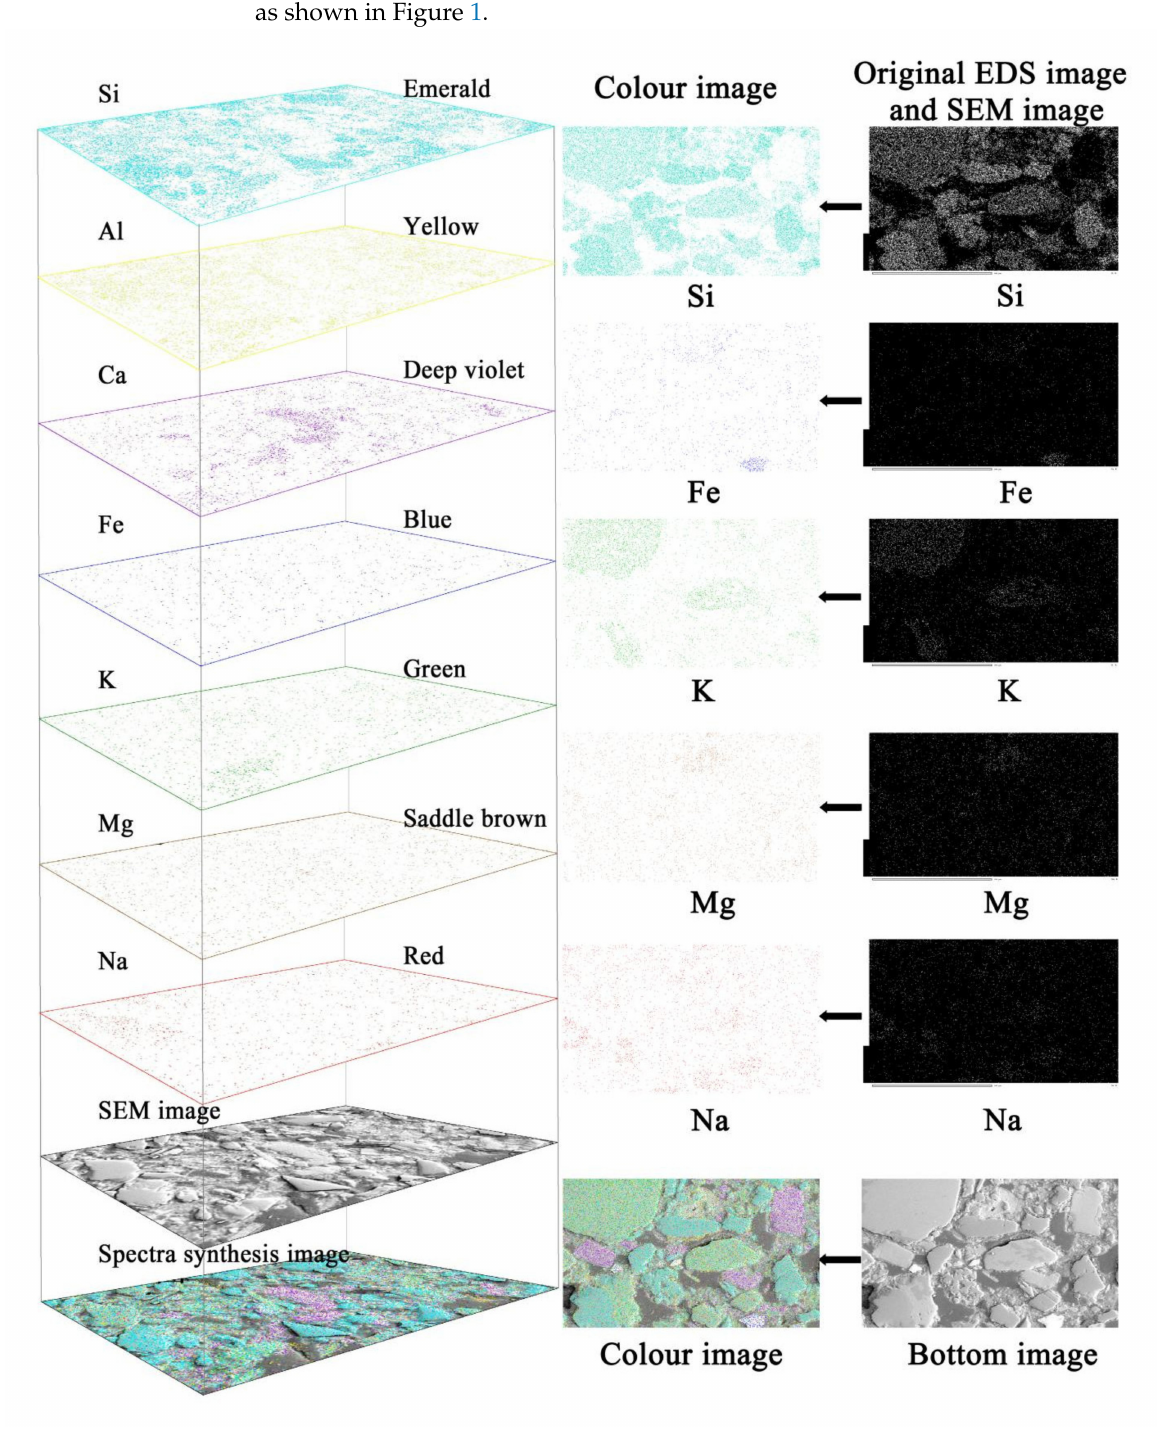
Figure 1. Element overlay